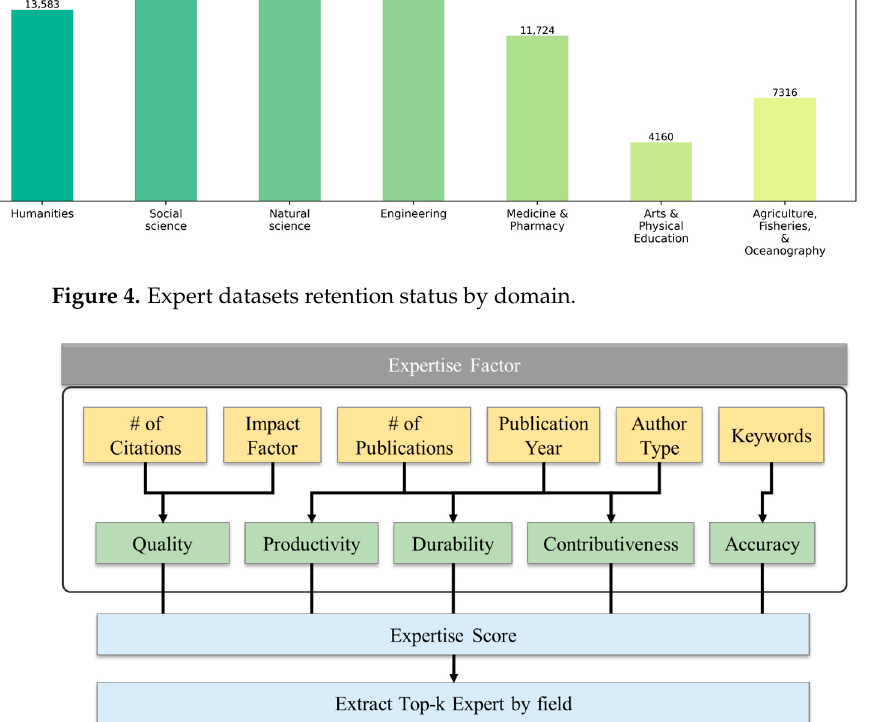
Figure 4. Expert datasets retention status by domain.